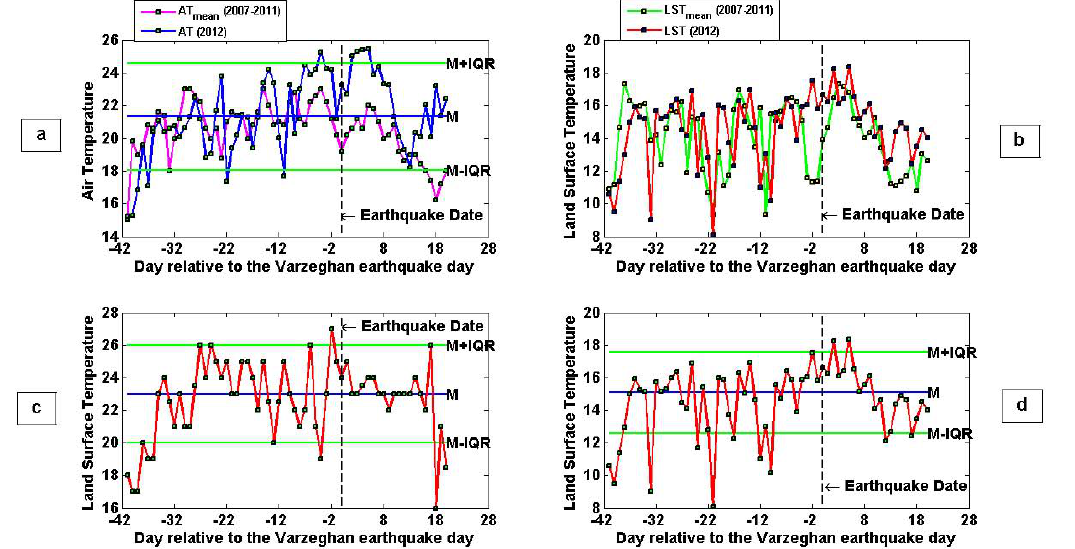
Fig. 2. (a) Results of air temperature data analysis for the Varzeghan earthquake (11 August 2012) from 1 July to 31 August 2012. The blue line with open squares represents the AT variations in 2012. The mean of AT during the same period from 2007 to 2011 is represented as a magenta line with open squares. (b) Same as (a) but for land surface temperature data. (c) The variations of the averaged LST of pixels along the fault line close to the epicenter from 01 July to 31 August 2012. (d) LST variations of epicenter obtained from night-time MODIS satellite images. The x-axis represents the day relative to the earthquake day. Median, and higher and lower bounds ( M ± IQR ) are seen as blue and green horizontal lines, respectively. The earthquake day is represented as a vertical dotted